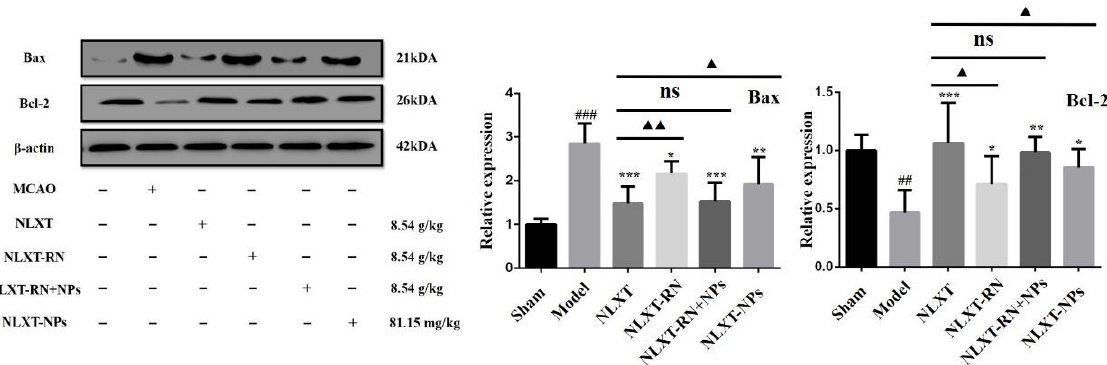
Figure 6. Effect of administration groups on the Bax/Bcl-2 protein expression level of MCAO rats (x ± s, n = 3). ## p < 0.01, ### p < 0.001, compared with sham group; * p < 0.05, ** p < 0.01, *** p < 0.001, compared with MCAO group; ns: no significant difference, compared with MCAO group; ▲ p < 0.05, ▲▲ p < 0.01, compared with NLXT group.